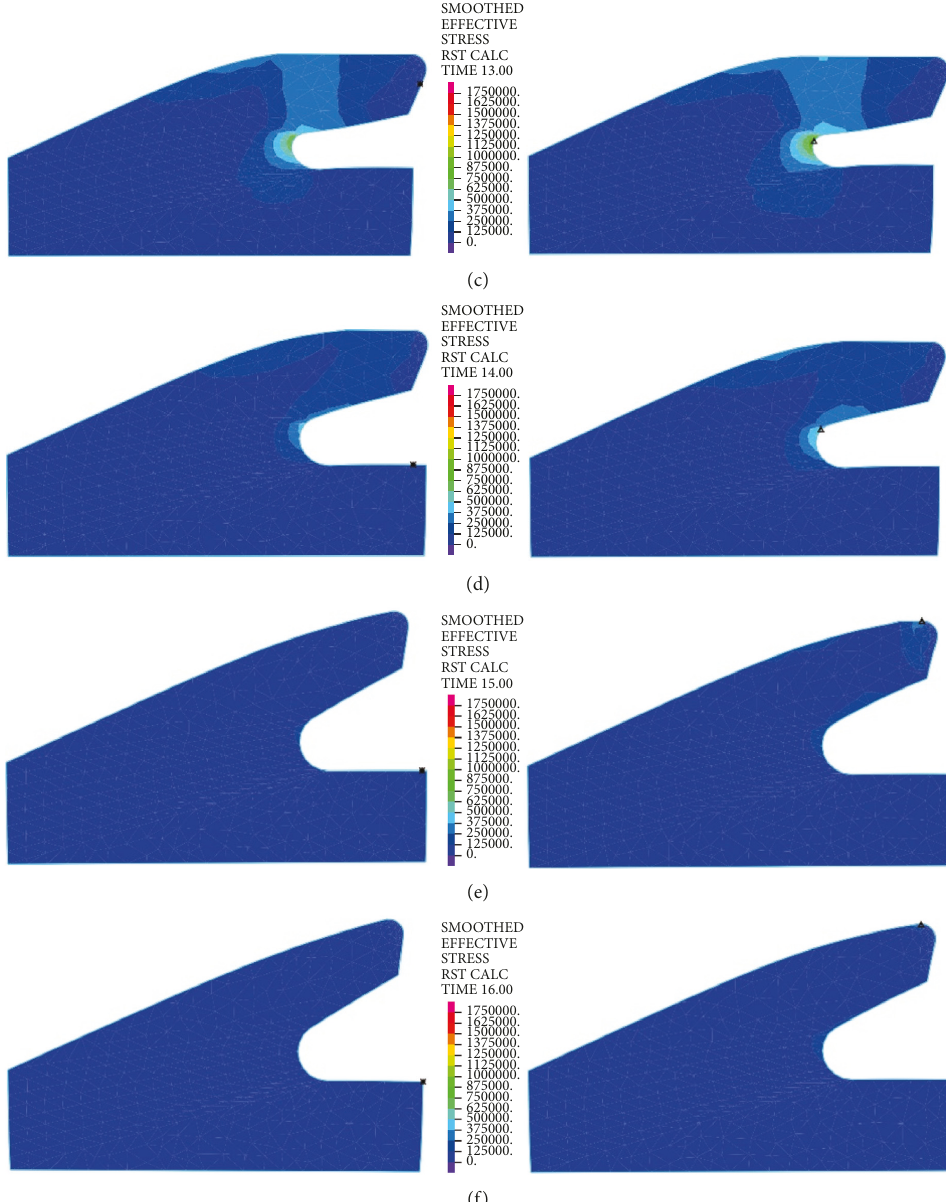
Figure 14: Effective stress distribution of the rubber rings after optimizing during anticlockwise rotation. (a) Deflection 0.2 ° . (b) Deflection 0.4 ° . (c) Deflection 0.6 ° . (d) Deflection 0.8 ° . (e) Deflection 1.0 ° . (f) Deflection 1.2 °